Question: What type of chart is this?
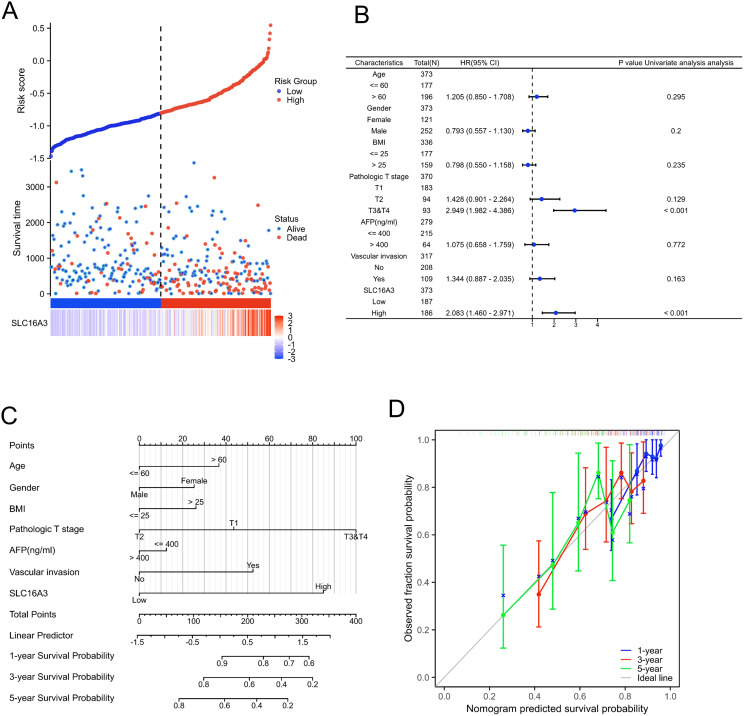
Answer: forest